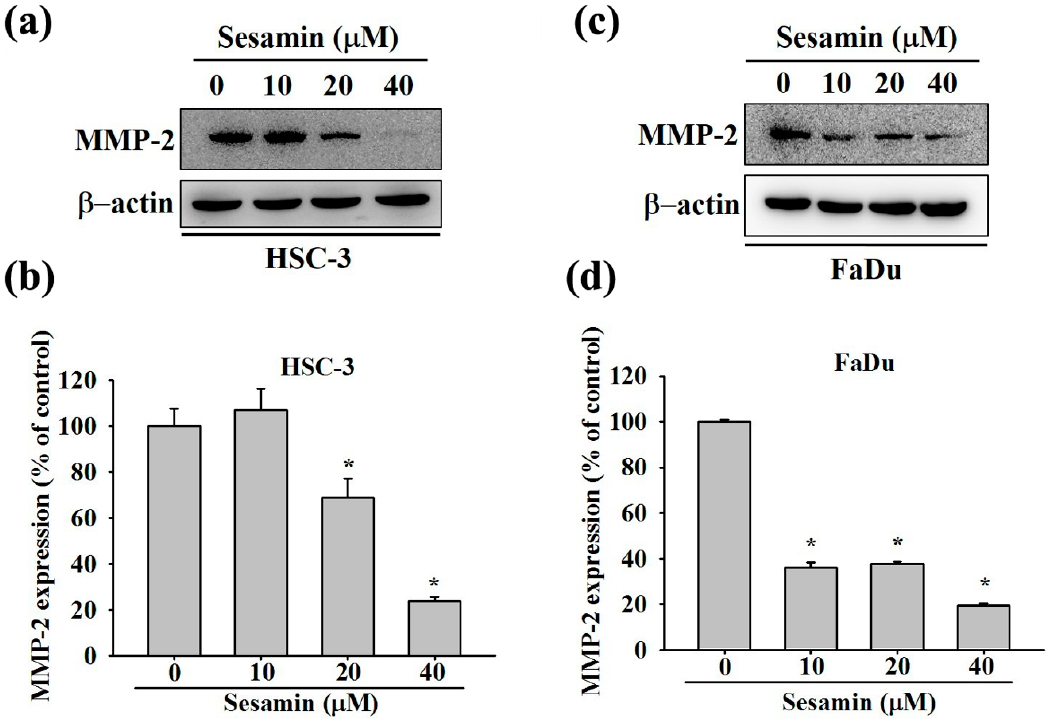
Figure 4. MMP-2 protein expression in human oral cancer cells following sesamin treatment. ( a ) HSC-3 and ( c ) FaDu cells were treated with different concentrations of SES (0, 10, 20, and 40 μ M), and the cell lysates were subjected to SDS-PAGE followed by Western blotting as described in Materials and Methods. ( b ) and ( d ) The quantitative results for the HSC-3 and FaDu cells, individually. MMP-2 protein expression after being normalized to β -actin. The values represent the means ± SD of at least three independent experiments. * p < 0.05, compared with the control group.